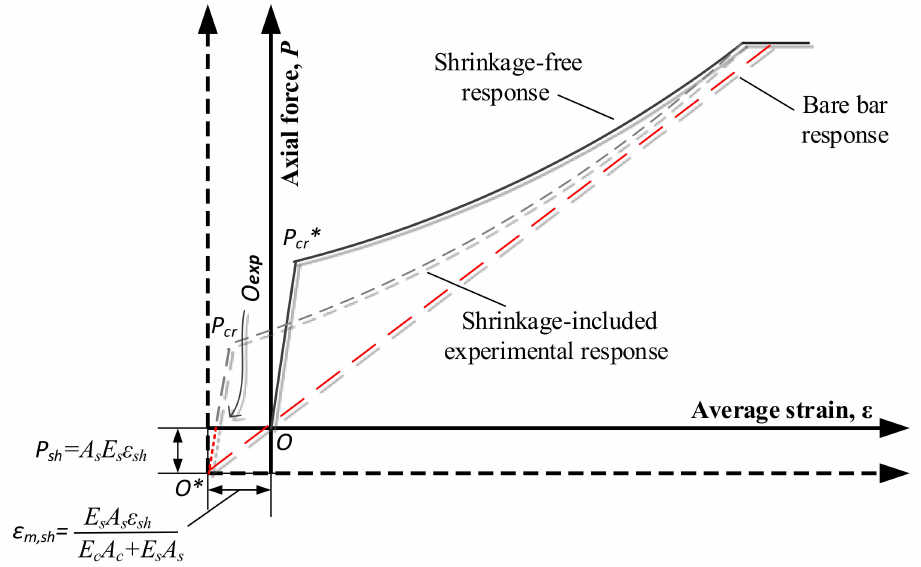
Figure 1. Shrinkage effect on the tension stiffening response of reinforced concrete (RC)